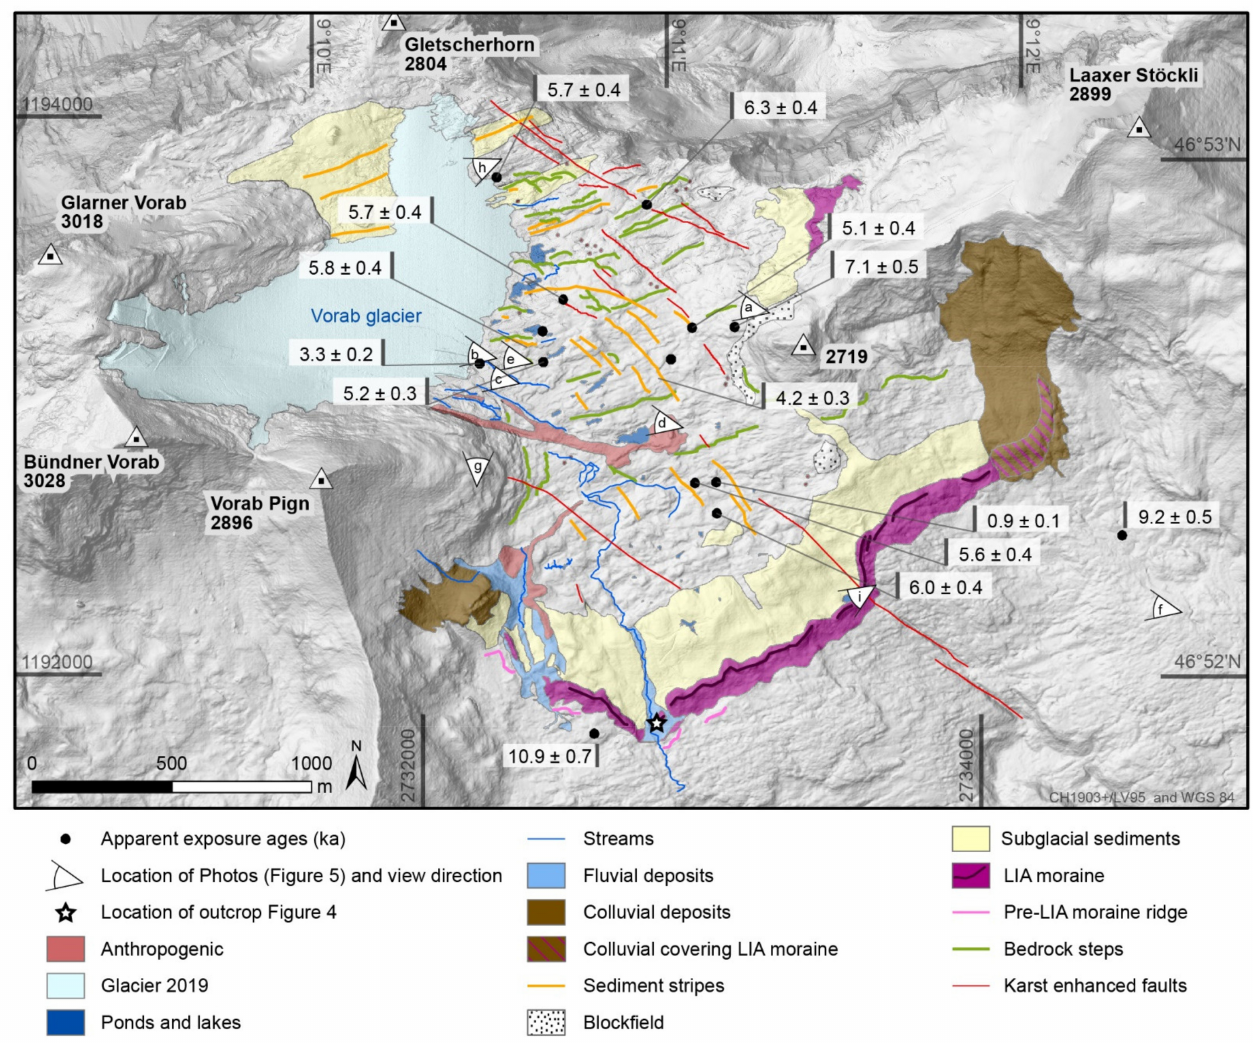
Figure 3. Geomorphological map of the Vorab glacier forefield showing the mapped features and the apparent 36 Cl exposure ages. Star shows the location of the described sedimentary outcrop (Figure 4). For location of the map see Figure